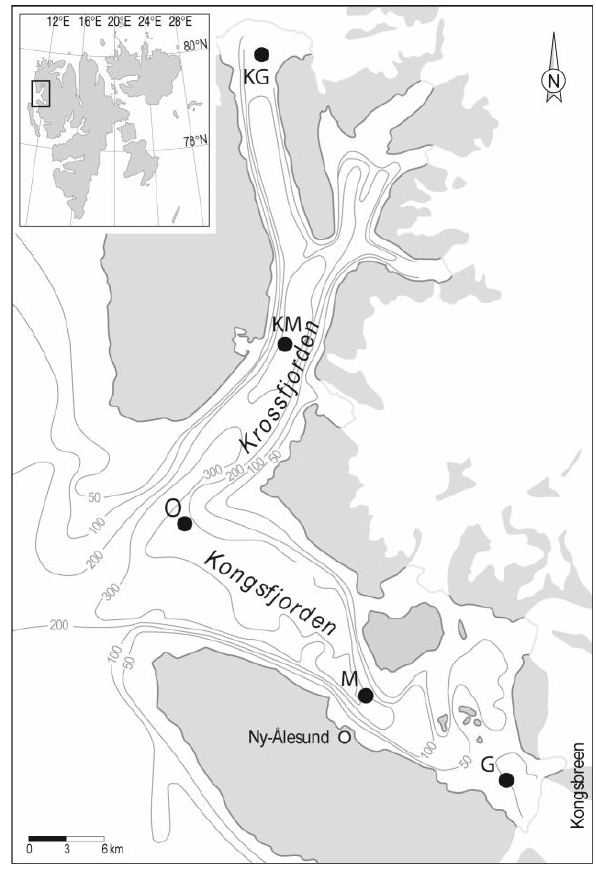
Figure 1. Bathymetric map of the Kongsfjorden - Krossfjorden system, and inlay map of3 Fig. 1. Bathymetric map of the Kongsfjorden–Krossfjorden system, and inlay map of Svalbard showing the location of the fjords. Sam- Svalbard showing the location of the fjords. Sampling locations Ocean (O), Kongsfjorden4 pling locations Ocean (O), Kongsfjorden Middle and Glacier (M Middle and Glacier (M and G), Krossfjorden Middle and Glacier stations (KM and KG) are5 and G), and Krossfjorden Middle and Glacier stations (KM and KG) are shown on the shown on the map.6